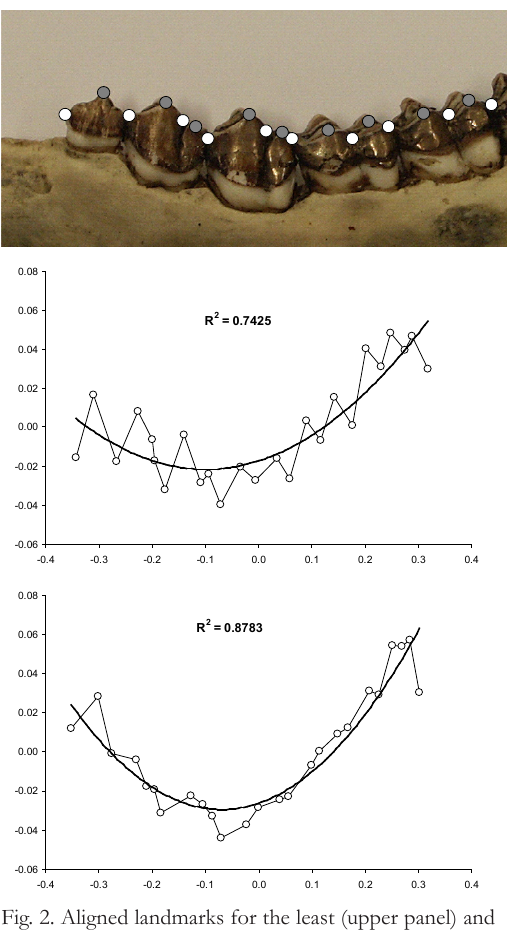
Fig. 2. Aligned landmarks for the least (upper panel) and most (lower panel) worn tooth line. The solid line is the best fit second order polynomial, used to ad - just for individual variation in the overall curvature of the tooth line. The x and y-axis relate to the relative coordinates of the landmarks after super-